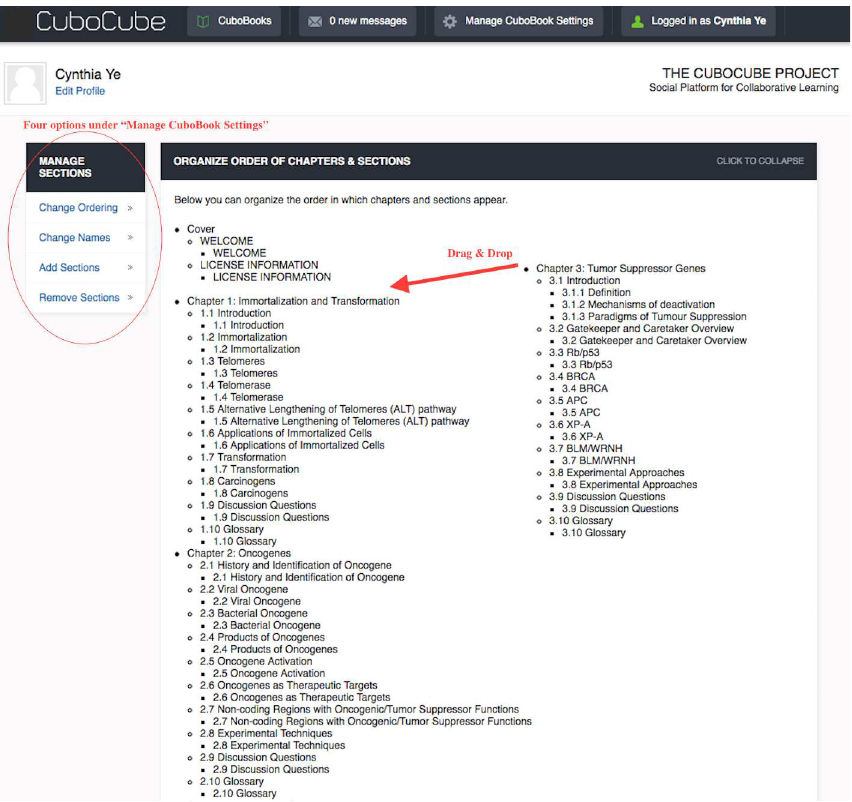
Fig 2. Textbook organization interface for instructors. Authors have the capacityto drag and drop sectionsto reorganizethe content of the